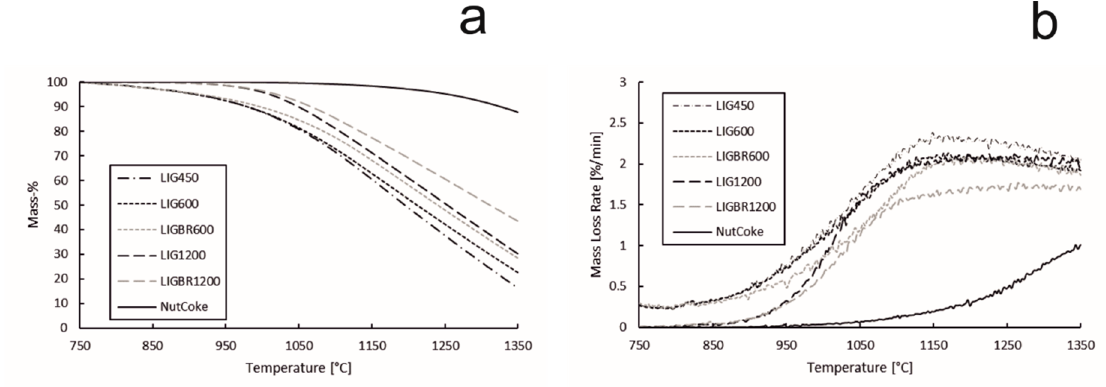
Figure 11. Gasification reactivity values of hydrolysis lignin chars and nut coke. ( a ): mass percentage of the samples during the gasification; ( b ): mass loss rate of the samples during the gasification.